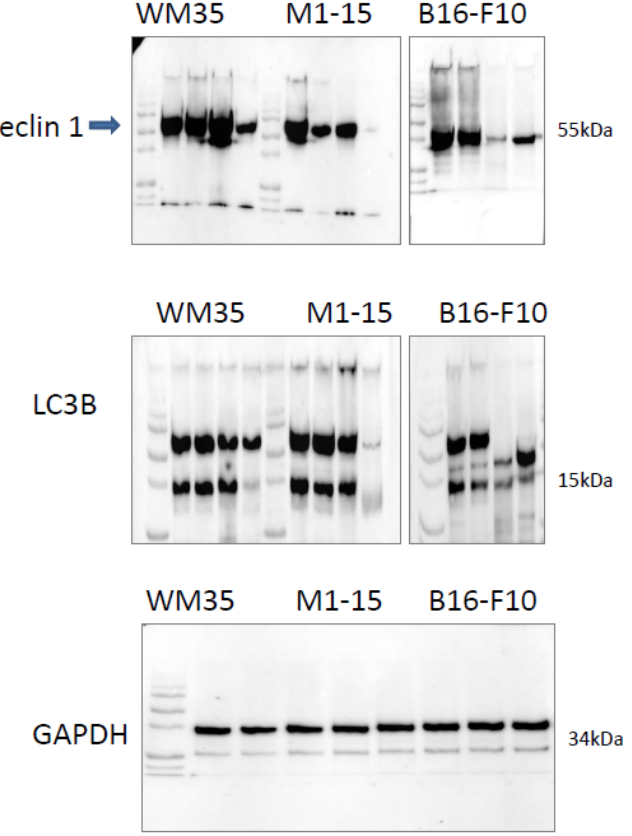
Figure A5. Original images WB Figure 9.